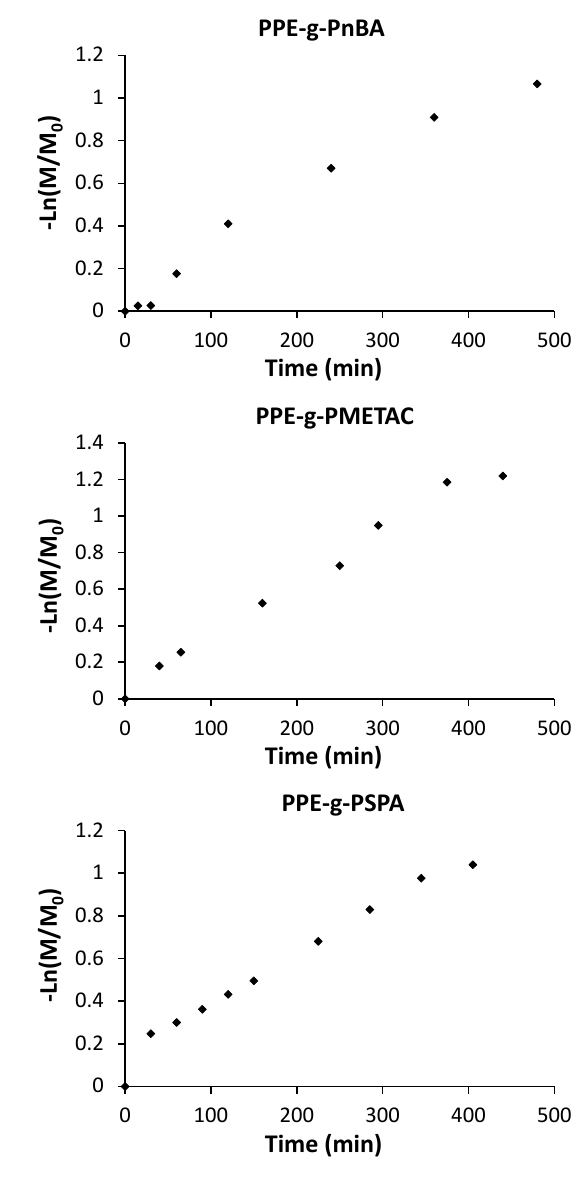
Figure 2. Kinetics of grafting of neutral (PnBA), cationic (PMETAC) and anionic (PSPA) grafts from PPVMI and PPEMI macroinitiators by ATRP.